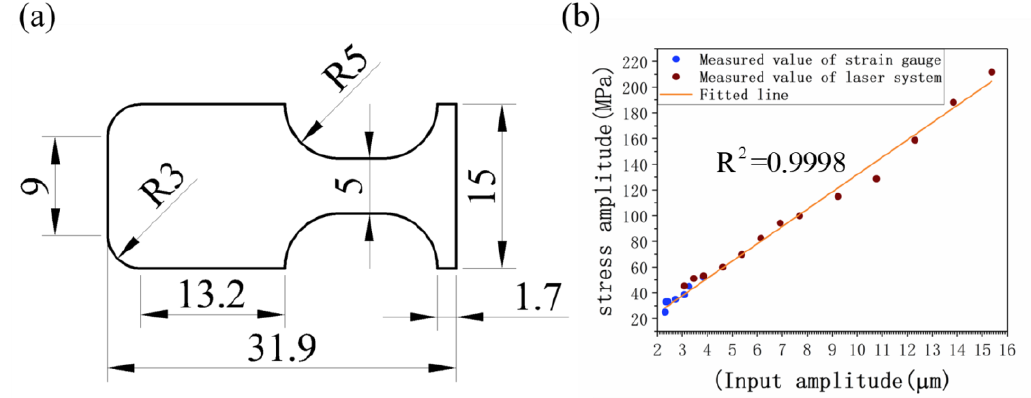
Figure 5. Laser measurement reliability verification: ( a ) Laser measurement standard sample size; ( b ) laser measurement data.